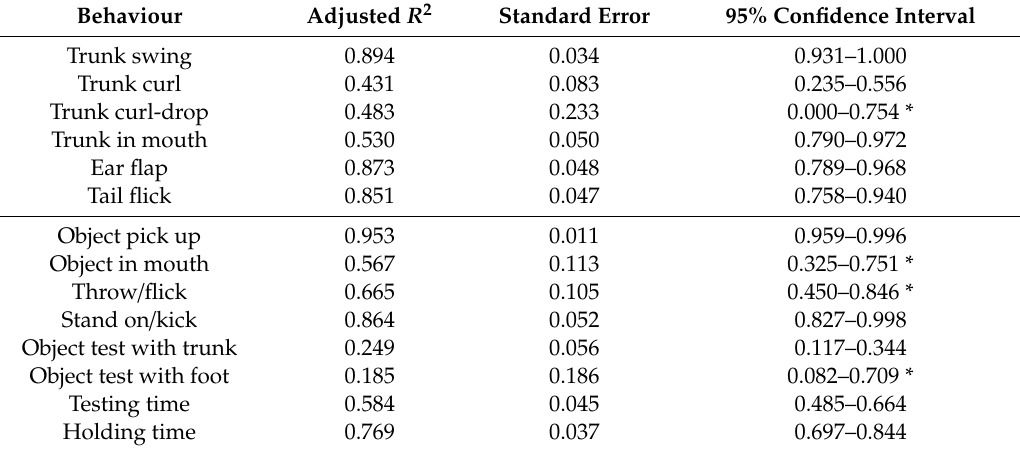
Table 4. Repeatability and error estimates for elephant behaviour. General behaviours (Table 1a) above the dotted line and object-directed behaviours (Table 1b)